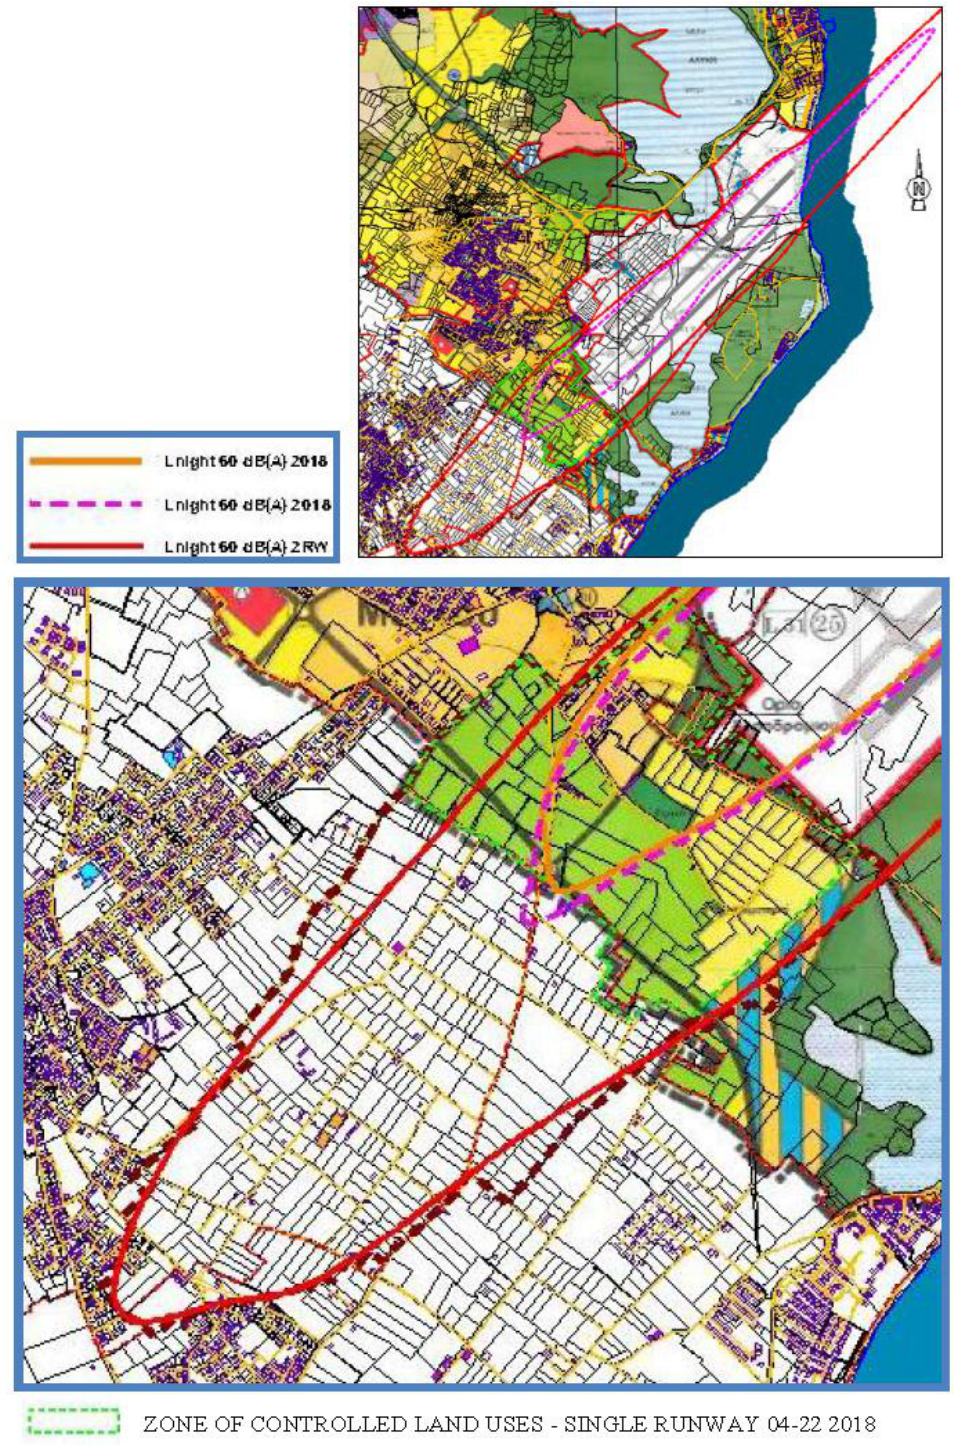
Figure 11: Proposed Land Uses Action Plan